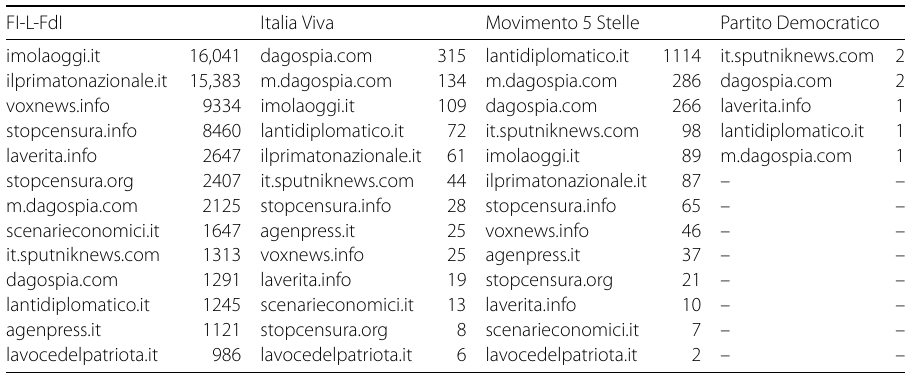
Table 6 List of the most frequent NR domains, with relative occurrences, per political subcommunities. The count was made considering all posts for users of the direct validated network FI-L-FdI Italia